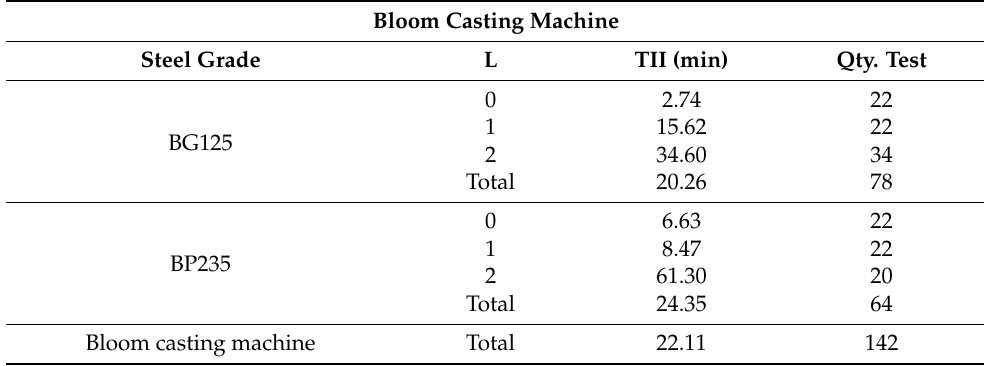
Table 4. TII in bloom casting machine, grouped according to steel classes and active lines.